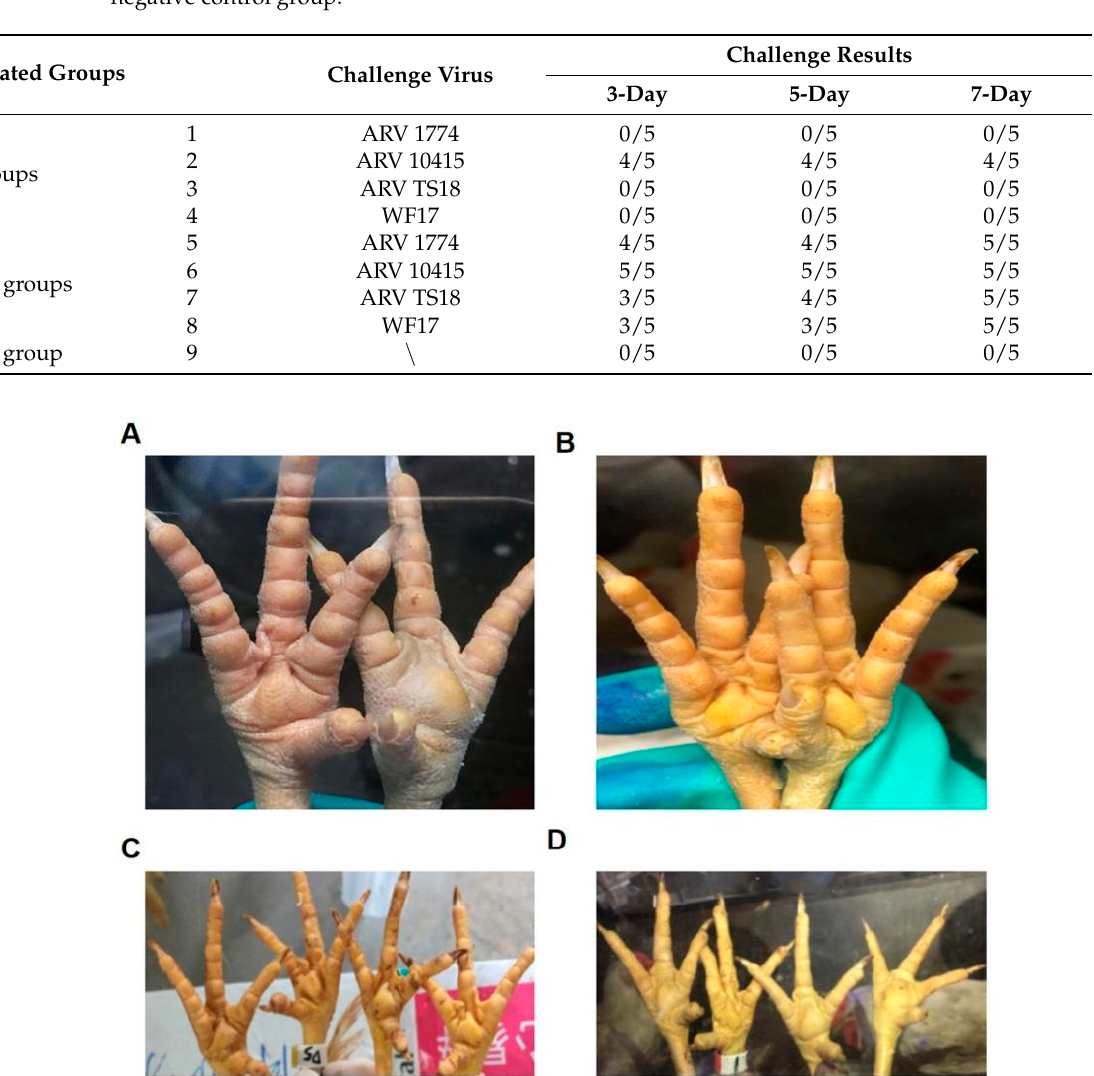
Figure 3. Clinical symptoms in each group after the challenge. ( A ) The footpads of the challenge control group were swollen; ( B ) The footpads of the negative control group were developing normally. ( C ) The footpads of vaccinated group 1 were not evidently swollen; ( D ) The footpads of vaccinated group 2 were obviously swollen. 4. Discussion ARV infection has brought great economic losses to poultry farming, emphasizing the importance of continuous research on the prevalence, genetic characteristics, and pathogenicity evolution of emerging ARV strains [13,14]. New ARV strains were discov- ered in South Korea in 2014 [15]. In addition, several new ARV strains were isolated from broiler flocks vaccinated against ARV in North America in 2016, and several new ARV strains were isolated in western Canada from 2012 to 2017 [11]. However, compared to the abundant information on ARV strains in other countries, few new ARV strains have been identified in China. From 2019 to 2020, 2340 samples of suspected ARV infection were collected from 16 provinces in China, and 113 ARV samples were identified as ARV- positive by RT-PCR; 46 ARV strains were successfully isolated, enriching the Chinese ARV virus library. The hosts infected by these positive samples were primarily white- feathered broilers. ARV strains were not detected in laying hens or yellow-feathered broil- ers. The time of onset was primarily 15–45 days. The main provinces affected were in eastern China, including Shandong, Jiangsu, Anhui, Fujian, Hebei, Henan, Heilongjiang, Jilin, and Liaoning. The σ C protein is the most variable protein in ARV, located on the surface of the viral capsid. It can produce group-specific neutral antibodies that play an important role in the infection and pathogenicity of ARV [16]. Therefore, according to the σ C gene sequence of different ARV strains, the relationship between the difference in sequences and the path- ogenicity and immunogenicity of the strains can be analyzed, and the cross-protection of antibodies among different strains can be studied [10]. Sequence homology analysis was performed based on σ C. The results showed that, in addition to the 20,199,330 strain, the homology of the other 45 strains with S1133 was relatively low at 52.8–76.2%, and among